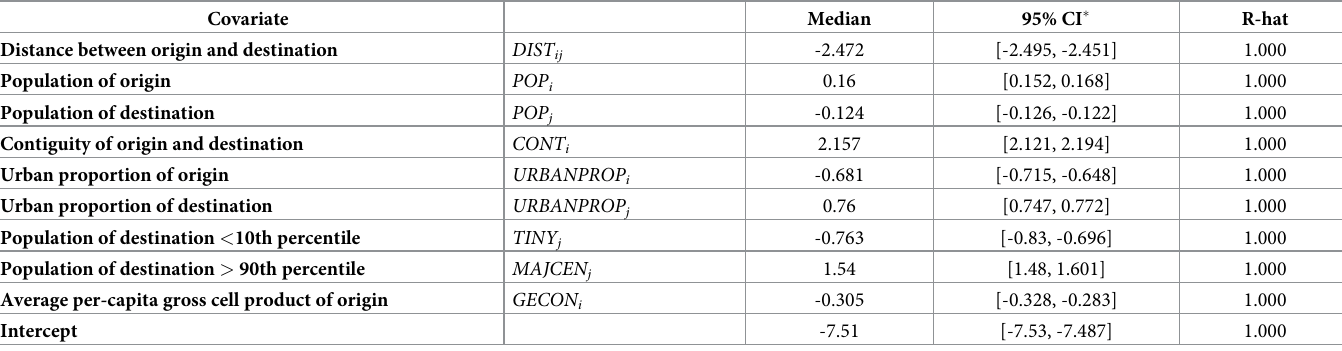
Table 3. Coefficients of the best fine-scale